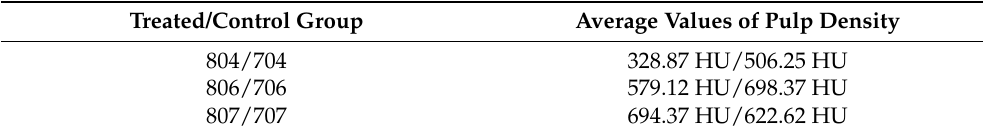
Table 2. Average values of pulp density (HU) measured on CT scans in all treated and control groups. Treated/Control